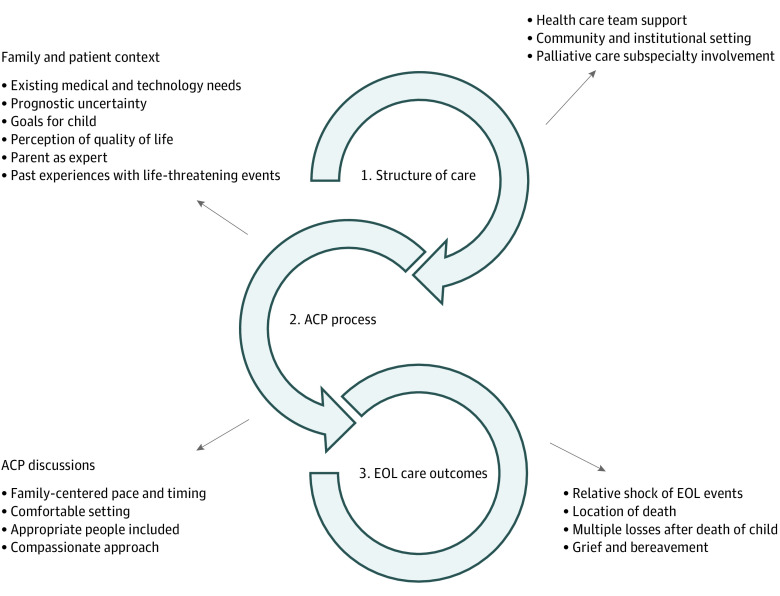
Advance Care Planning (ACP) Themes and SubthemesEOL indicates end of life.